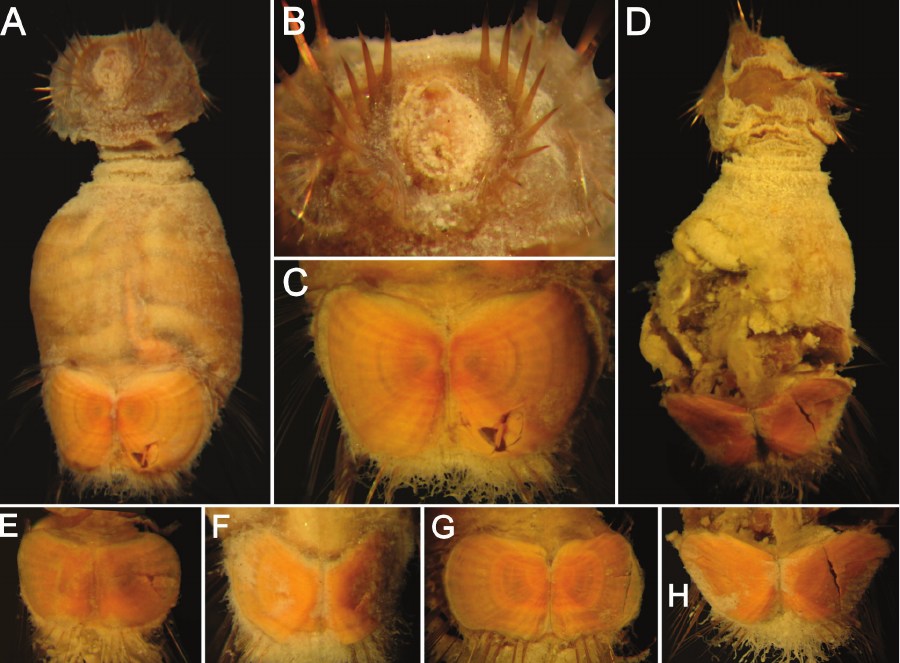
Figure 9. Sternaspis williamsae sp. n., holotype (LACM 5353) A Frontal view B Anterior end, oblique frontal view C Ventro-caudal shield D Largest paratype (LACM 5354), ventral view E – H Ventro-caudal shields, frontal view. Bars: A, G 0.9 mm B, H 1 mm C 0.5 mm D 1.2 mm E 0.4 mm F 0.6